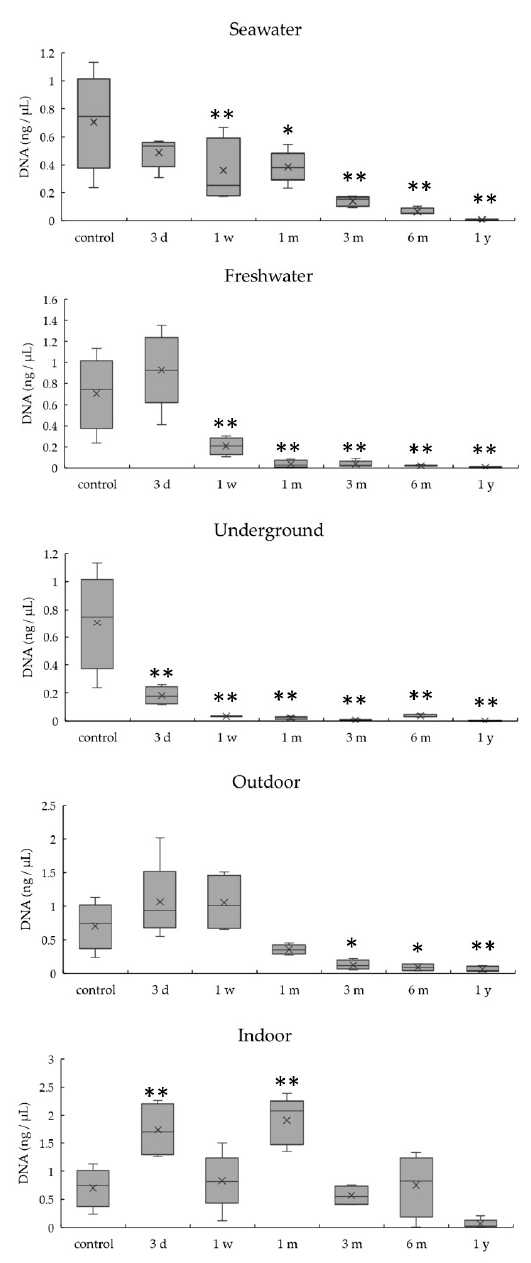
Figure 2. DNA quantitation of a 404 bp target by real-time PCR in bones exposed to five environmental conditions for 1 year. Data are presented as means and standard deviations. * p < 0.05 vs. control, ** p < 0.01 vs. control.